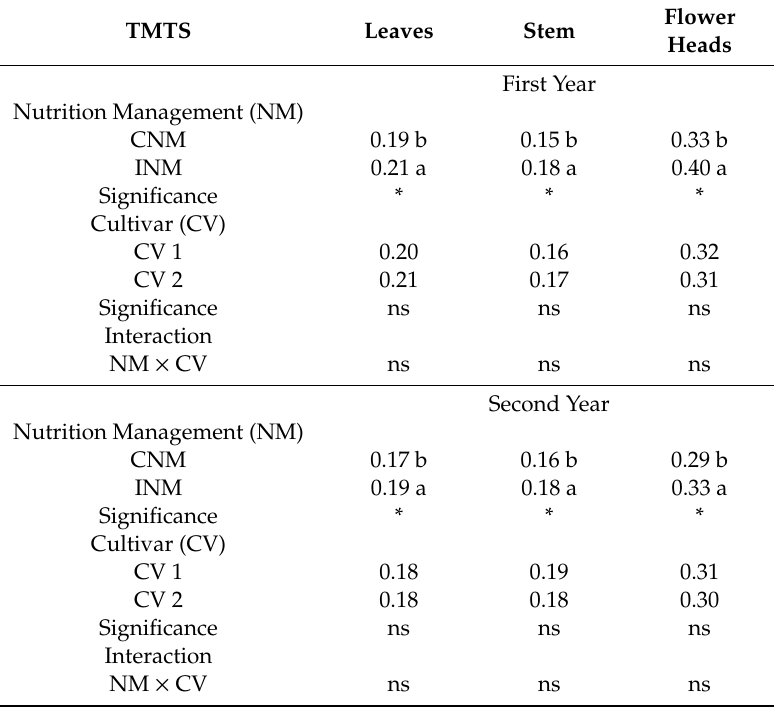
Table 8. Main e ff ects of nutrient management and cultivar on phosphorus content (%) in di ff erent organs at harvest in chrysanthemum plants over the two years of application.